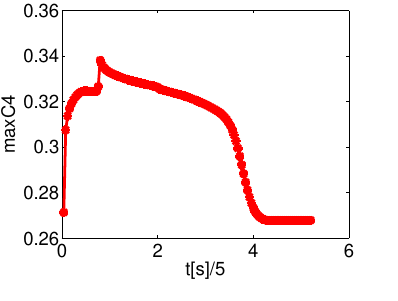
Figure 16. Levels of the axial velocity at t f